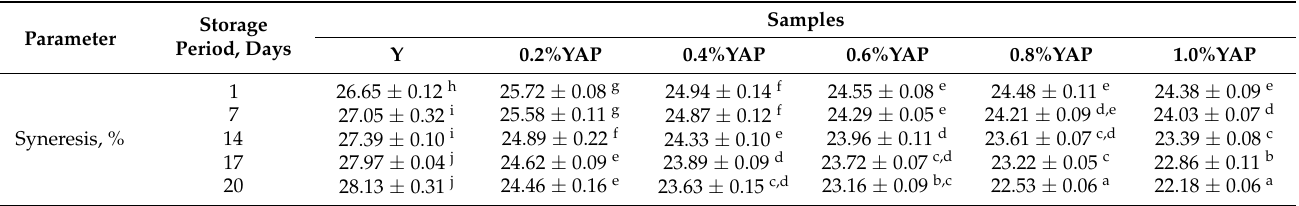
Table 8. Syneresis evolution of yogurt with apple pomace powder during